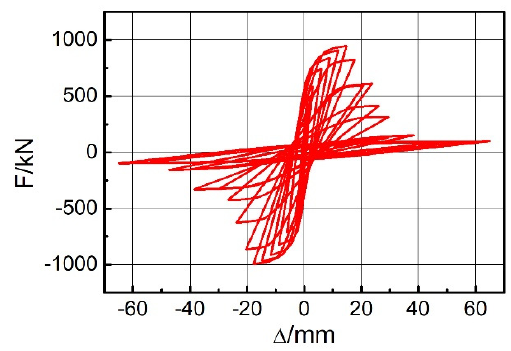
Figure 10. Hysteresis curves of the EDCW bearing capacity.